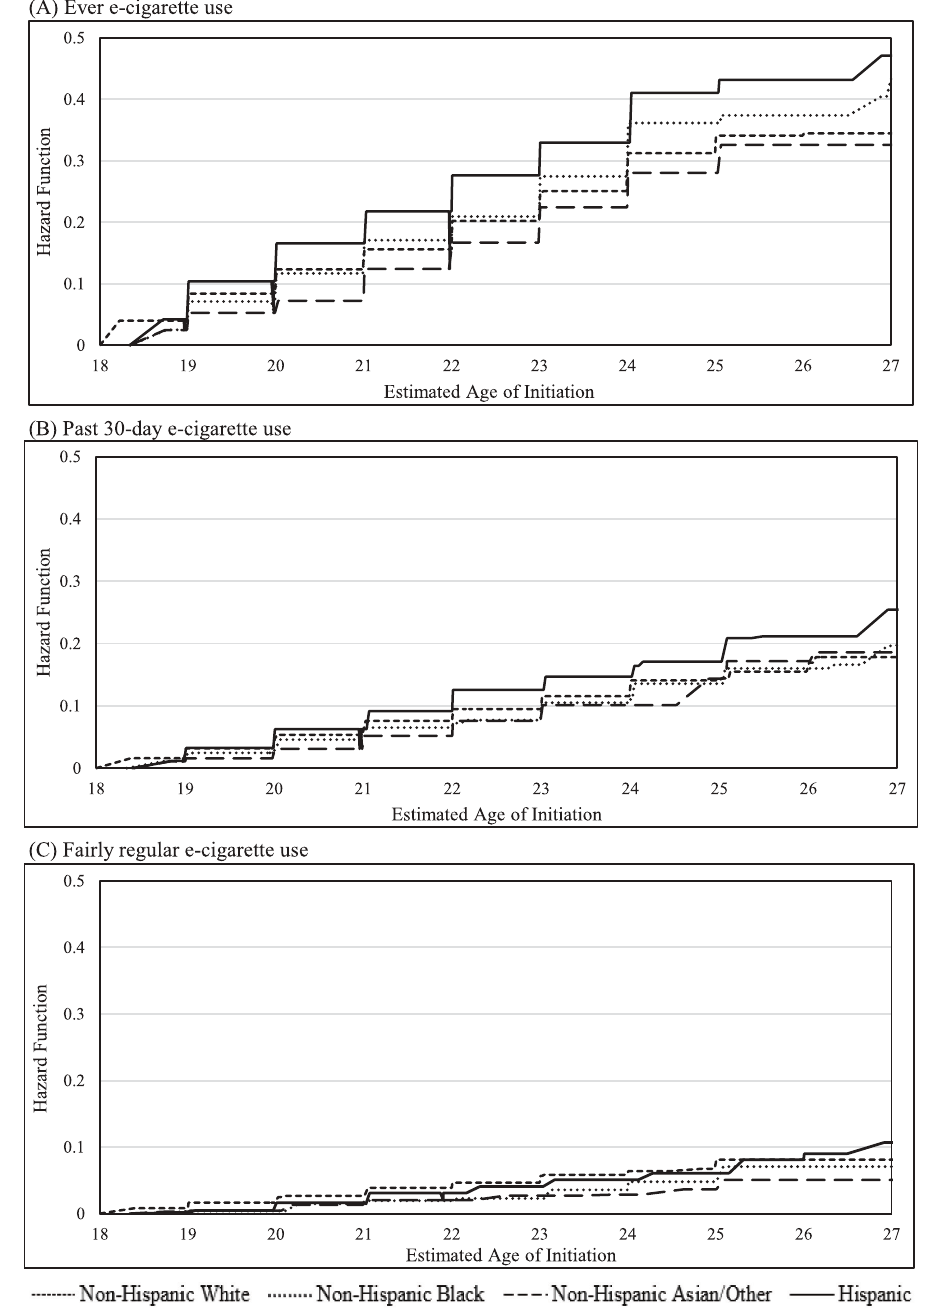
Fig 3. Estimated age of e-cigarette initiation in PATH young adults stratified by race/ethnicity. Hispanic White (2.7%), ages 24 and 25 for Hispanic (4.4%), ages 26 and 27 for Non-Hispanic Black (3.8%), and ages 25 and 26 for Non-Hispanic Other young adults (4.3%). By age 25, 8.1%, 6.1%, 7.1% and 5.1% of Non-Hispanic White, Hispanic, Non-Hispanic Black, and Non- Hispanic other young adults initiated fairly regular e-cigarette use.